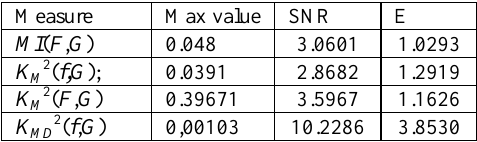
Table 3 Numeric data for TV-IR matching (Example